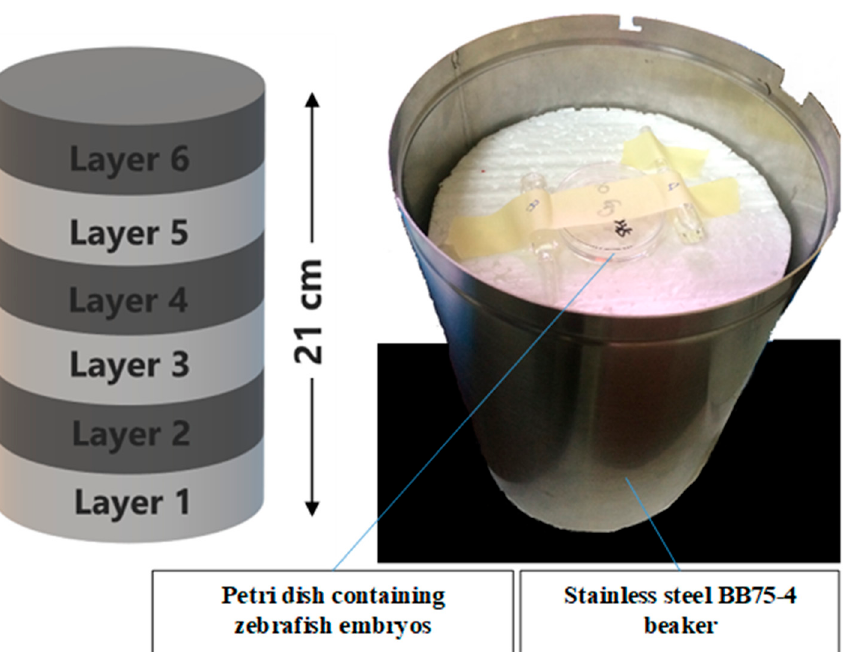
Figure 11. The position of petri dish containing zebrafish embryos in the stainless steel BB75-4 beaker for irradiation.